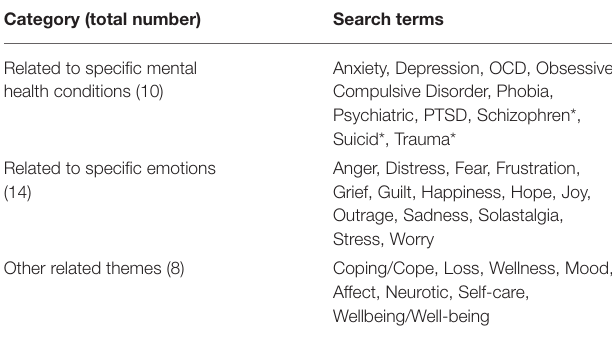
TABLE 1 | Key terms identified through Search A and used in Search